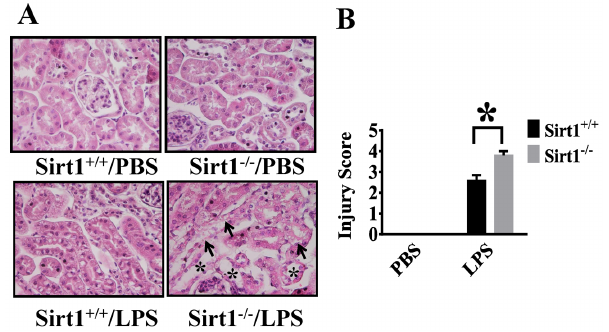
Figure 2. Aggravated renal tubular injury in Sirt1 knockout mice after LPS challenge. Kidney tissues were harvested 24 h after LPS challenge (n=5 mice/group). The collected kidneys were stained with H&E staining. (A) Histological examination shows increased tubular injury in kidney cortex of Sirt1 2 / 2 mice after LPS challenge, including tubular dilatation, flattening (*) and vacuolization (arrows). (B) Quantitative evaluation of morphological tubular damage 24 h after LPS challenge. *P , 0.05 versus Sirt1 + / + /LPS